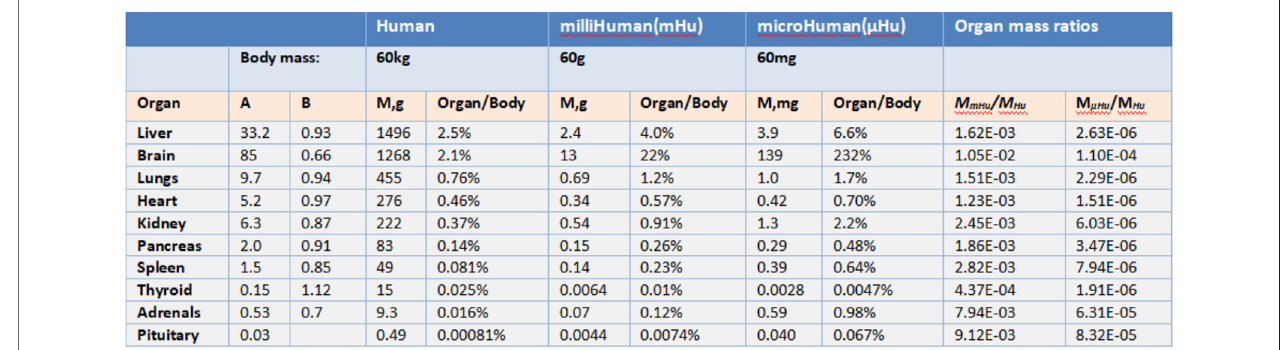
FIGURE 2 | Allometric scaling coef fi cients and organ masse (Adapted from Wikswo et al., 2013b).